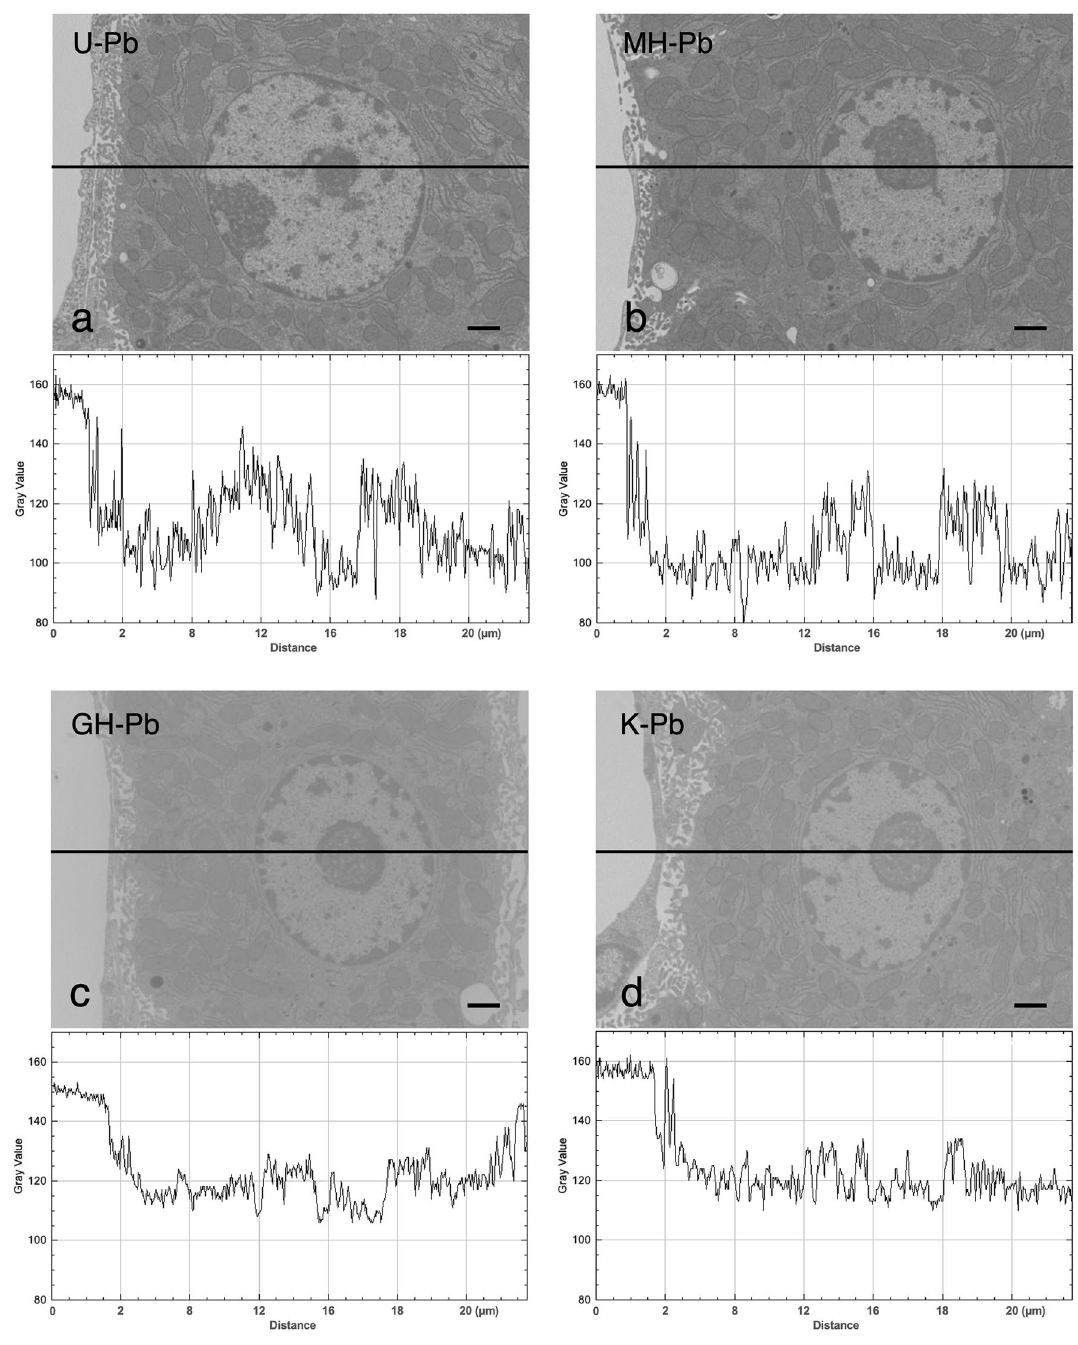
Figure 2. Quantitative analysis of mouse hepatocytes stained with UA, MH, Gill No.3 and Kernechtrot followed by RPb. Digital images were subjected to gray-level (i.e. contrast) line analysis using ImageJ image processing software to semi-quantitatively determine image quality. The line profile displaying two-dimensional graphs of the intensities of pixels along black lines within the images. The x-axis represents distance along the line and the y-axis is the pixel gray-level intensity. The gray level of each pixel is represented by 256 gradations of gray, with pixel value 0 being black and pixel value 255 being white. ( a ) UA-RPb and line profile, ( b ) MH-RPb and line profile, ( c ) Gill No.3-RPb and line profile and ( d ) Kernechtrot-RPb and line profile. Bar = 2